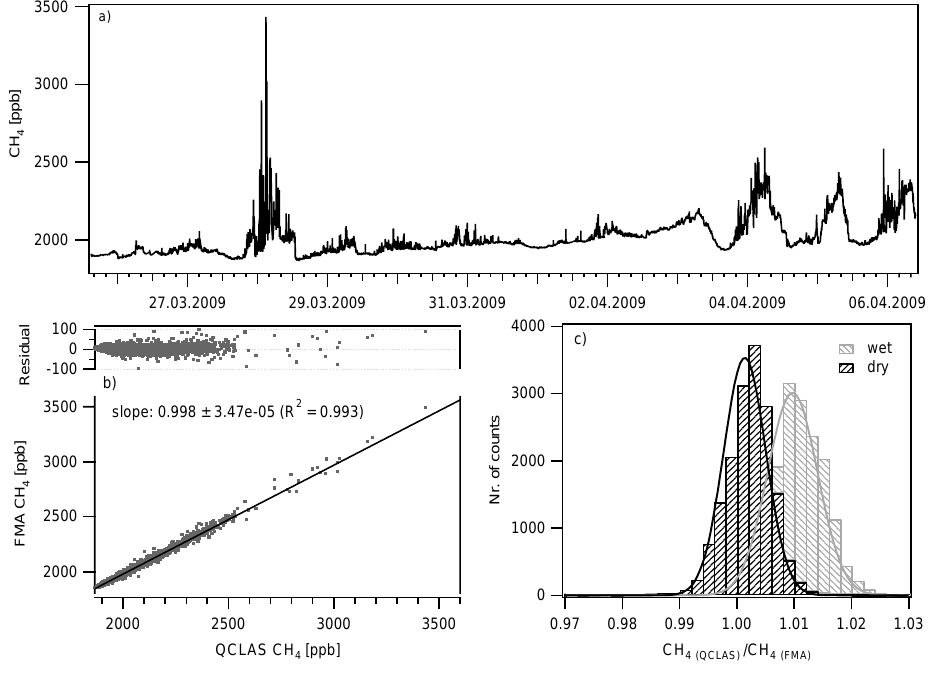
Fig. 5. (a) Time series of the methane mixing ratios during the field campaign measured by QCLAS. (b) Scatter plot between the data sets measured by QCLAS and FMA, and (c) a histogram plot of the ratio between these two data sets illustrating two situations: the ratio calculated using CH 4 measured by the FMA in humid air (gray bars) and the ratio when the FMA data were dilution corrected (black bars). The appended gaussian fit indicates that the ratio between the two data sets has a nearly normal